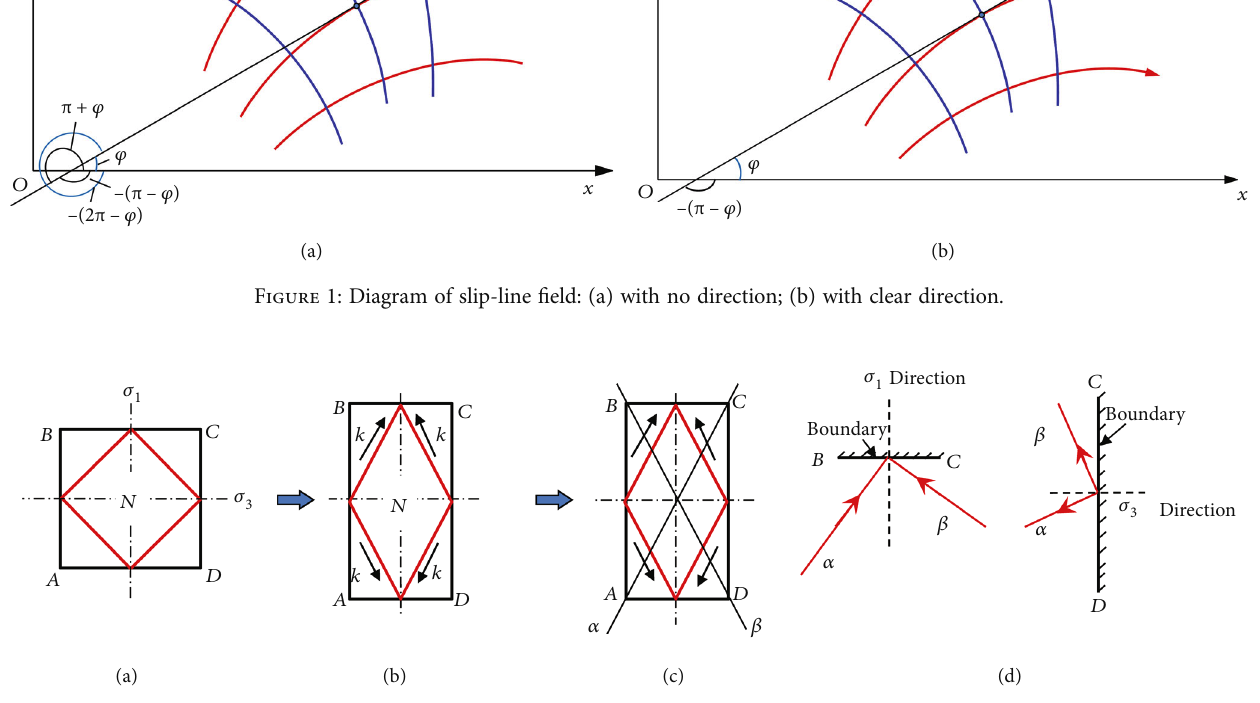
Figure 2: Determination of slip-line direction at stress boundary: (a) direction of principal stress; (b) predicted deformation tendency; (c) determined type of slip line; (d) direction of slip lines at boundary.